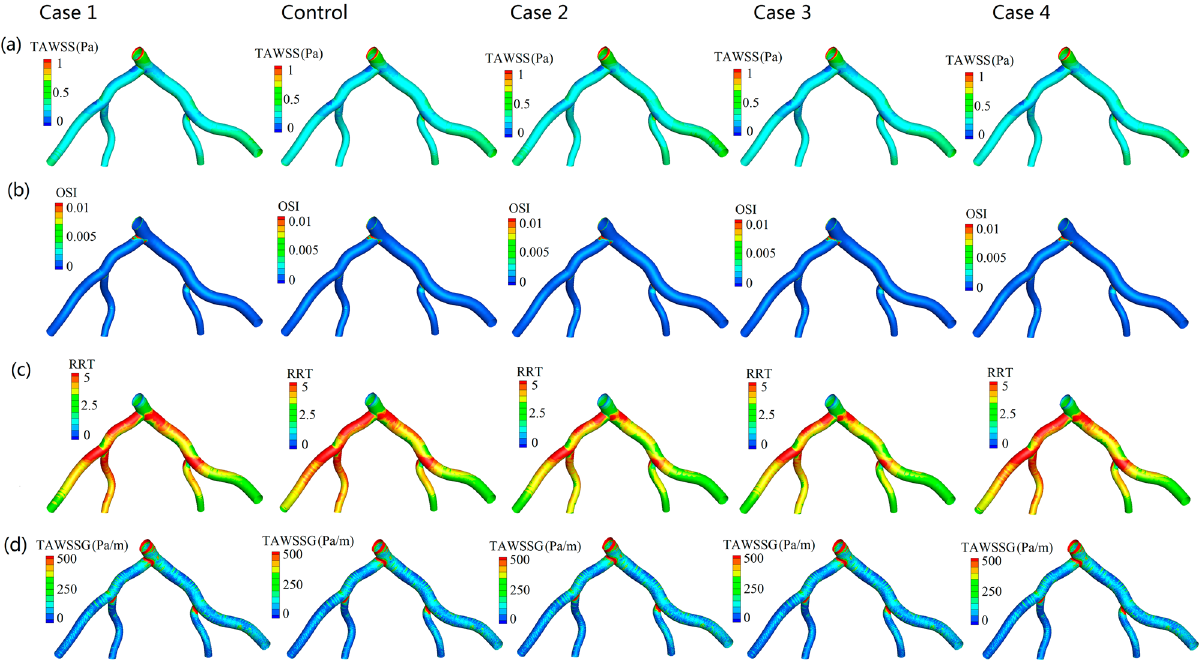
Figure 5. Wall shear stress-based hemodynamic indicators distributions for the five simulations. ( a ) The distribution of time-averaged wall shear stress. ( b ) The distribution of oscillatory shear index. ( c ) The distribution of relative residence time. ( d ) The distribution of time-averaged wall shear stress gradient. TAWSS time-averaged wall shear stress, OSI oscillatory shear index, RRT relative residence time, TAWSSG time- averaged wall shear stress gradient.